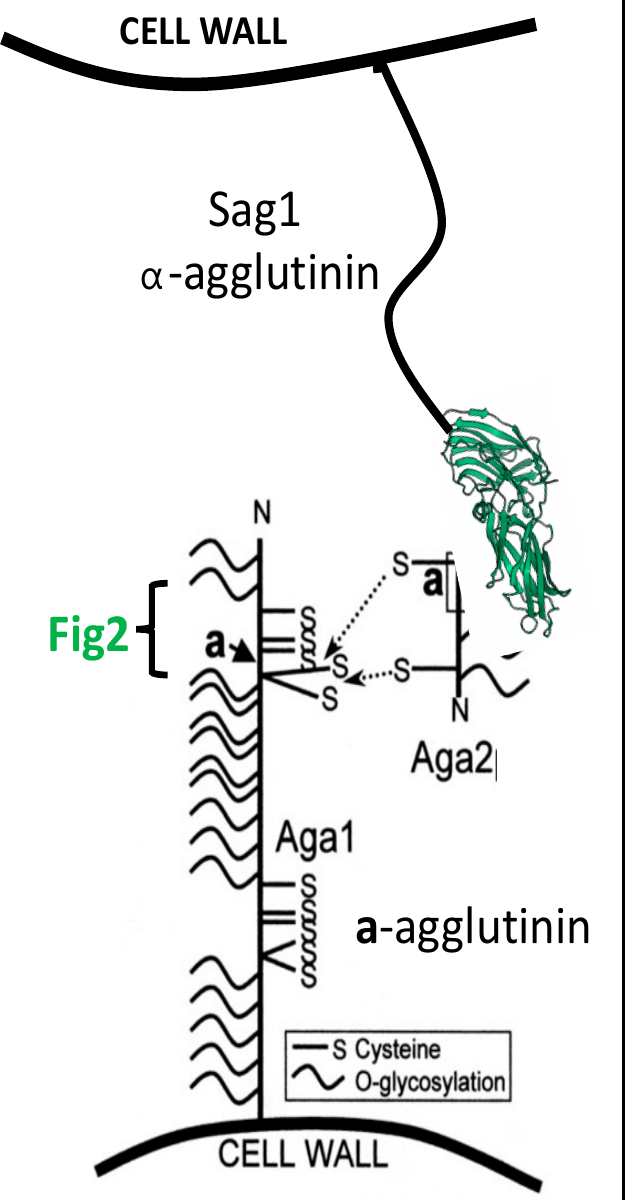
Figure 4. S. cerevisiae sexual agglutinins. α -Agglutinin (Sag1) expressed on α -cells is shown at the top , binding to the C-terminal sequence of its ligand Aga2. Aga2 is a disulfide-bonded subunit of a -agglutinin expressed on the surface of a -cells (bottom). The a -agglutinin Aga1 subunit is expressed on both mating types and can also bind to the adhesin Fig2 within the bracketed region. Adapted with permission from [61]: 2001, Peter Lipke.